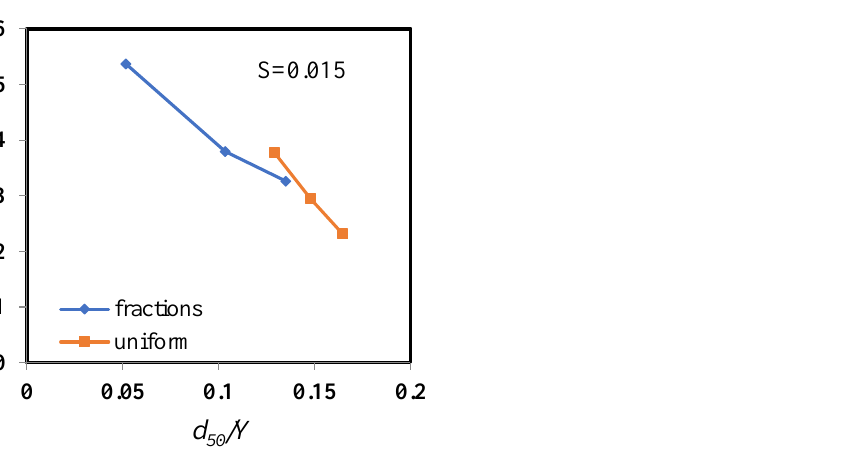
Figure 7. Comparison between the particle Froude number of the uniform and graded fractions corresponding to 5.17, 10.35, and 14 mm in a bed slope of 0.015.